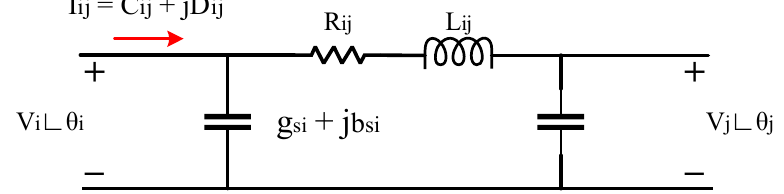
Figure 3. Model π two inputs of a branch of the power grid.